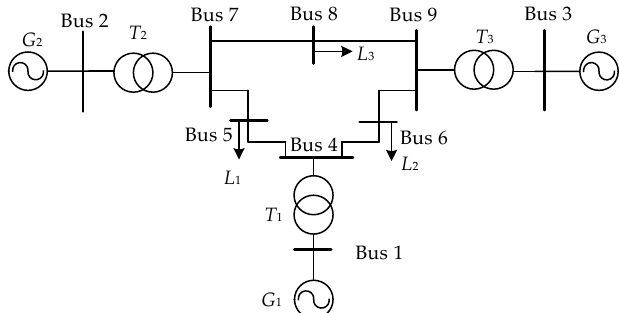
7 of 16 Figure 5. Effect of frequency on C eq and L eq . 3.3. Effect of Grid-Connected Inverter on Impedance Distribution